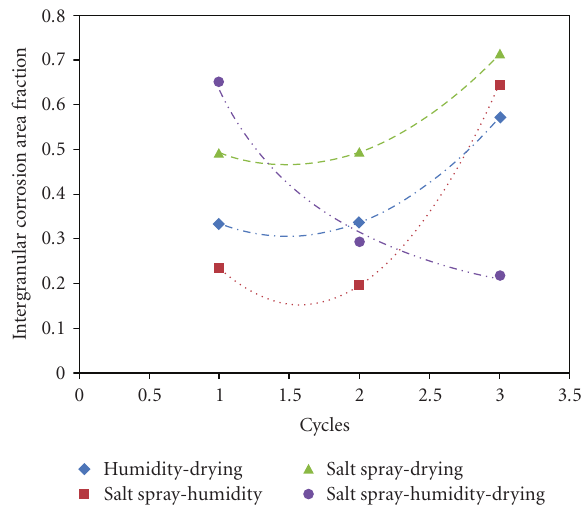
Figure 6: Average intergranular corrosion area fraction of the AE44 coupons arranged by test condition based on cycle